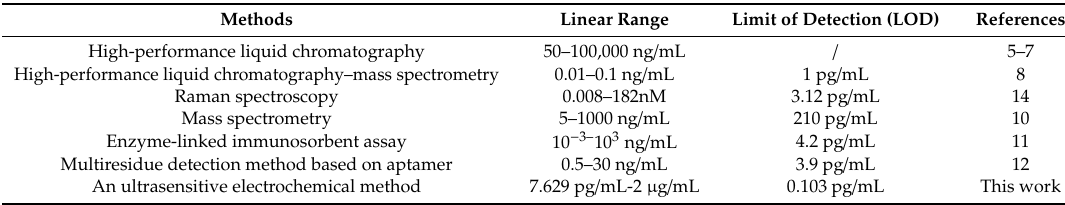
Table 2. Comparison of available methods for analysis of DEHP.